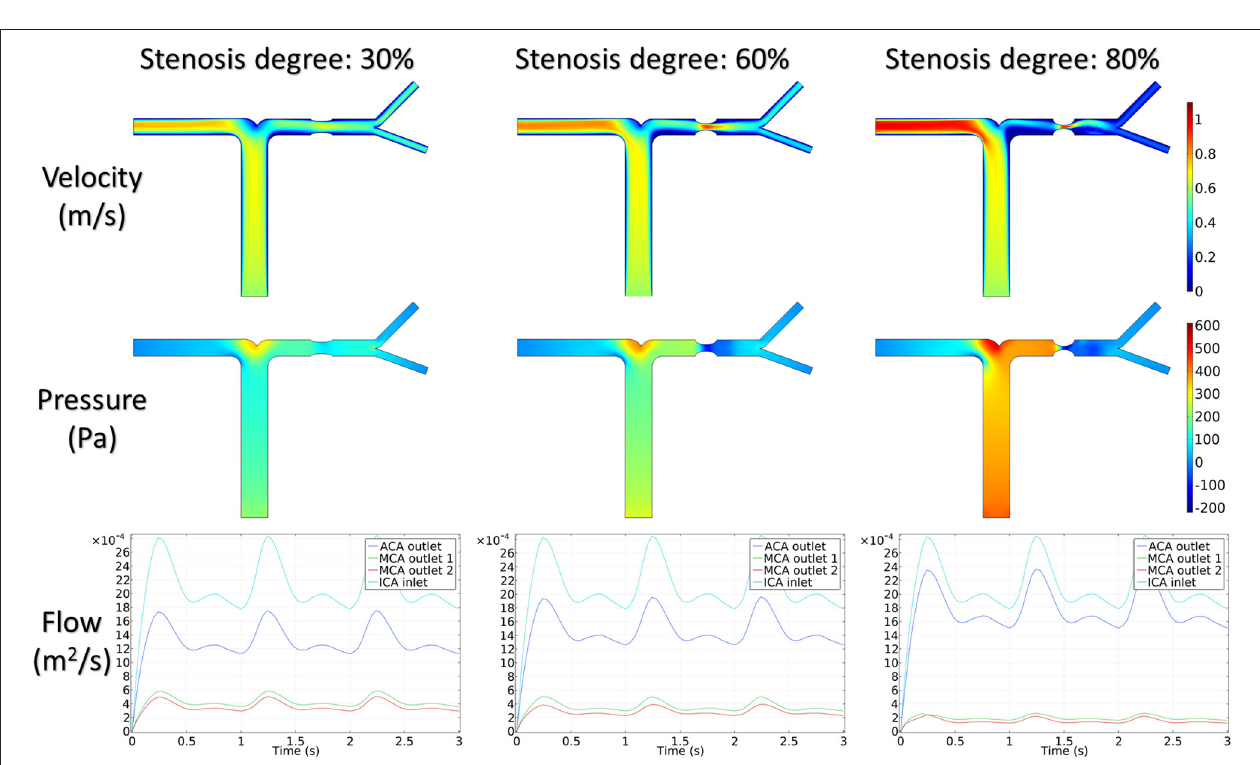
FIGURE 5 | Velocity, pressure, and inlet/outlet flow alternation with the degree of